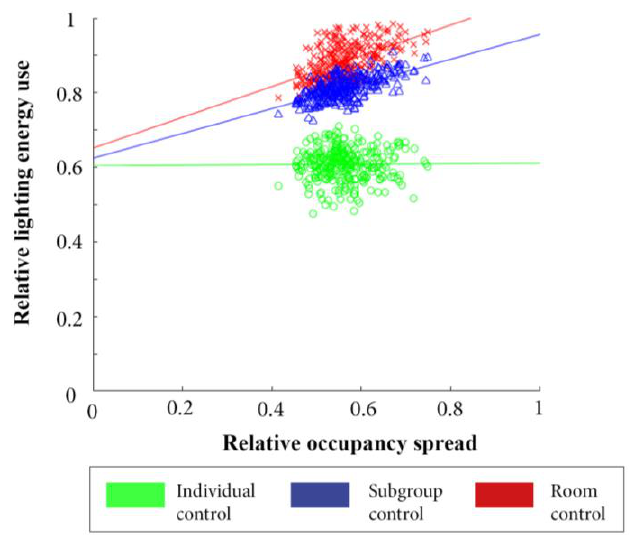
Figure 6. Relationship between lighting energy use and occupancy spread for the three different control strategies (individual control = green, subgroup control = blue, room control = red).